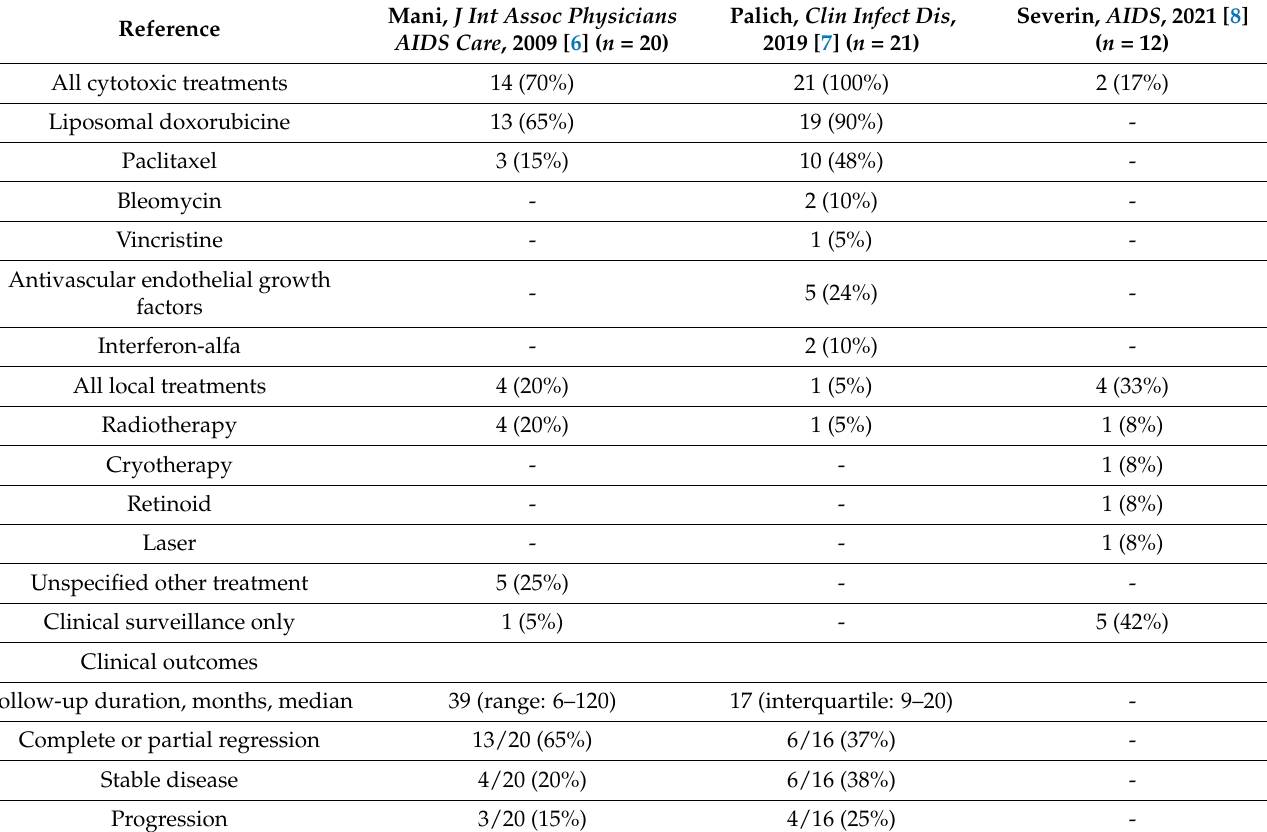
Table 3. Treatments used for the management of Kaposi’s sarcoma in HIV-patients with suppressed viremia, in addition to combined antiretroviral therapy, and clinical outcomes, in the main published series.